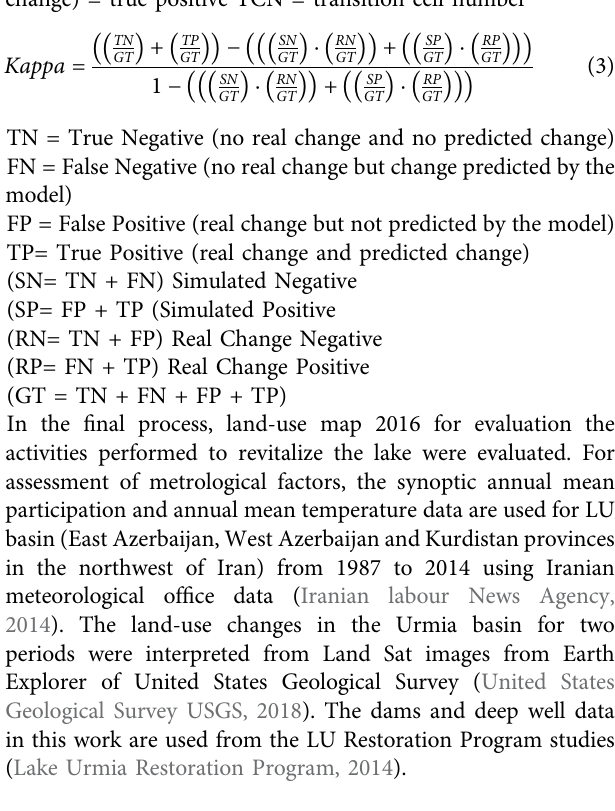
columns. Figure 2 . Show the methodological process for producing probability land- use change map. For assessment of the simulation and prediction process, RMS, percent